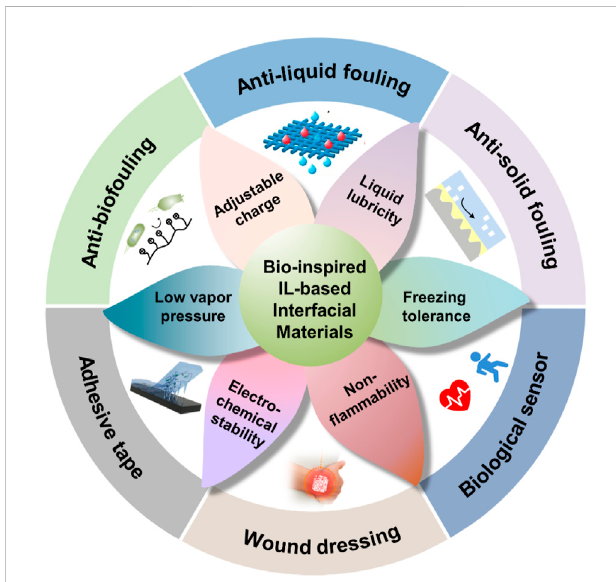
FIGURE 12 Unique properties and applications of BILIMs. BILIM inherits the advantages of ILs, such as charge adjustability and electrochemical stability, and shows promising potential applications in anti-adhesion (anti-biofouling, anti-liquid fouling, and anti-solid fouling) and adhesion (biological sensor, adhesive tape, and wound dressing). Reproduced with permission (Zhang et al., 2019). Copyright 2019, American Chemical Society. Reproduced with permission (Cho et